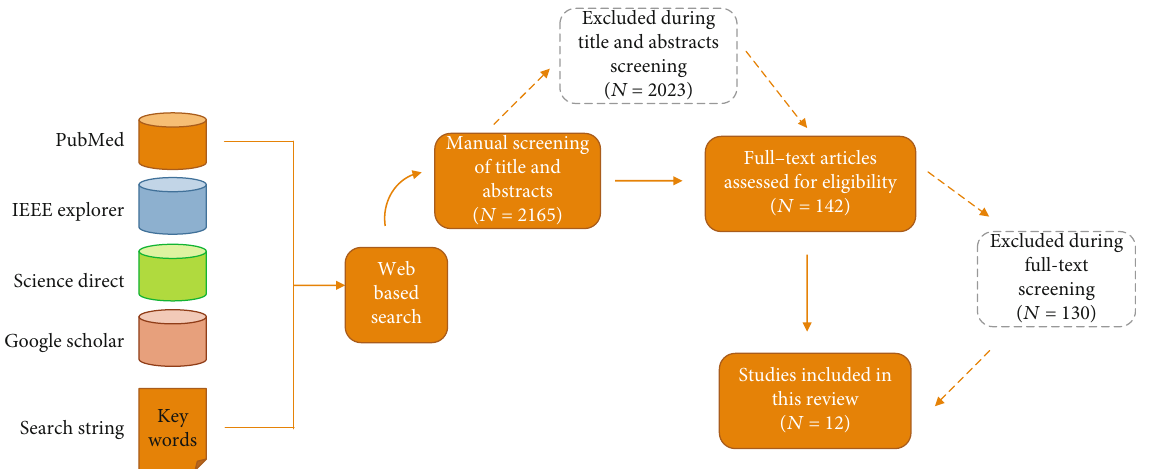
Figure 1: Work fl ow diagram showing the search and screening method